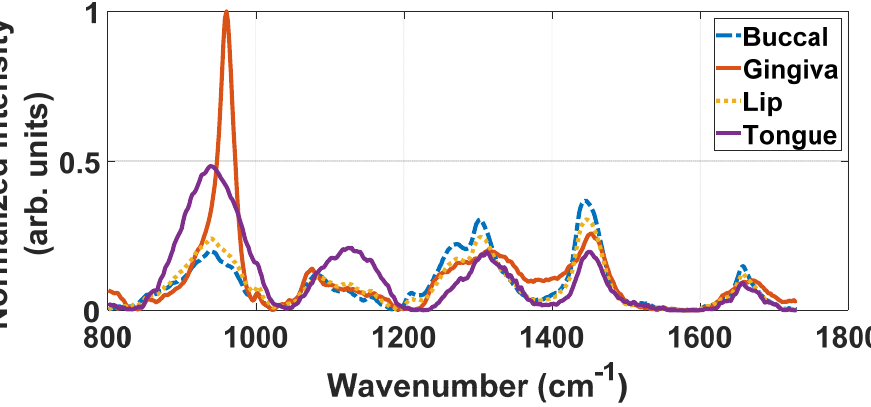
Figure 4. Average Raman spectra of buccal mucosa (blue), gingiva (red), lip (yellow) and tongue (purple) normalized (divided) by the maximum intensity value among all the average Raman spectra.